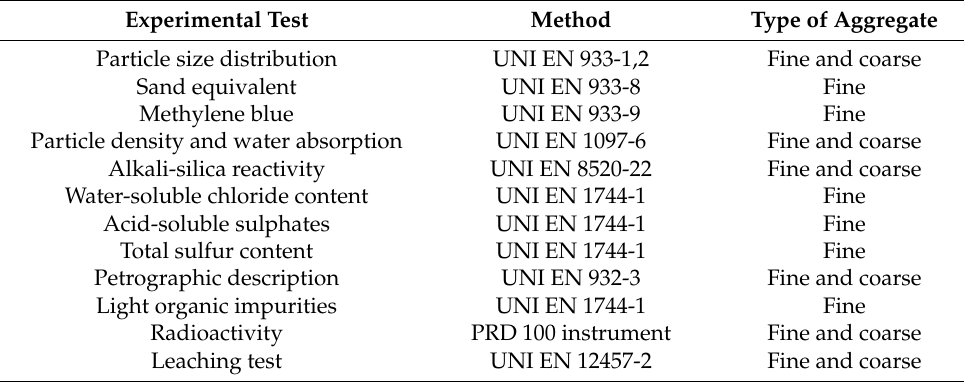
Table 1. Experimental tests carried out on fine and coarse recycled